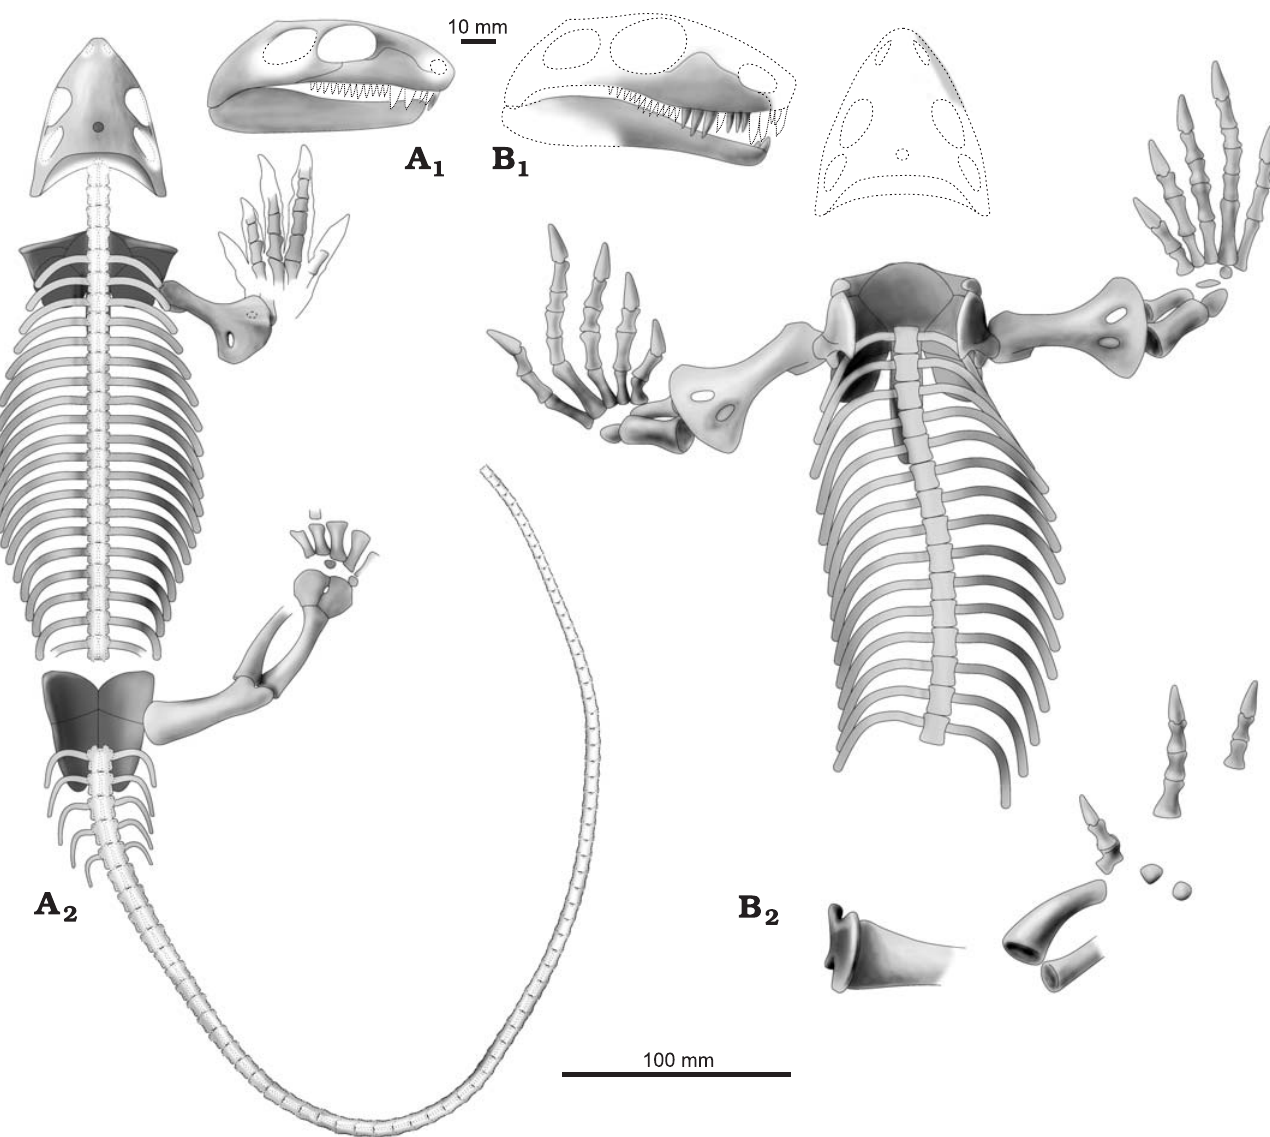
Fig. 5. Reconstructions of caseasaurian synapsid skeletons in dorsal views (A 2 , B 2 ) and lateral aspects of skulls (A 1 , B 1 ). A . Datheosaurus macrourus Schroeder, 1904 (Upper Pennsylvanian, Poland). B . Callibrachion gaudryi Boule and Glangeaud, 1893 (Cisuralian,